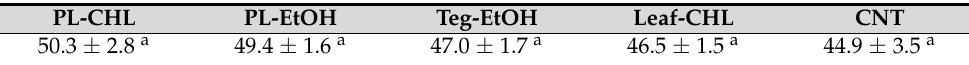
Table 2. Radial growth of A. flavus colonies exposed to C. colocynthis plantlets chloroform (PL-CHL) and ethanol (PL-EtOH) extracts, seed tegument ethanol extract (Teg-EtOH) and leaf chloroform extract (Leaf-CHL) at 500 µ g/mL concentration. The radial increment is expressed as the mean of daily radial increase of colonies radius (mm/d) ± S.D. The same superscript letters indicate the absence of statistically significant differences ( p < 0.005). PL-CHL PL-EtOH Teg-EtOH Leaf-CHL CNT 50.3 ± 2.8 a 49.4 ± 1.6 a